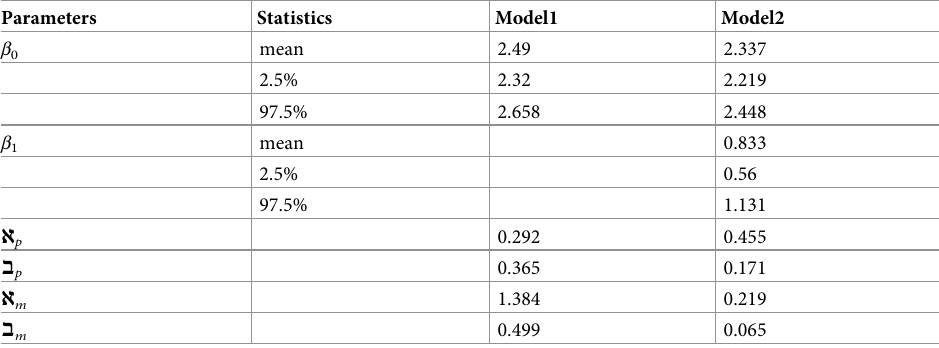
Table 1. Posterior means and 95% credible estimates for parameters (2.5% quantiles are